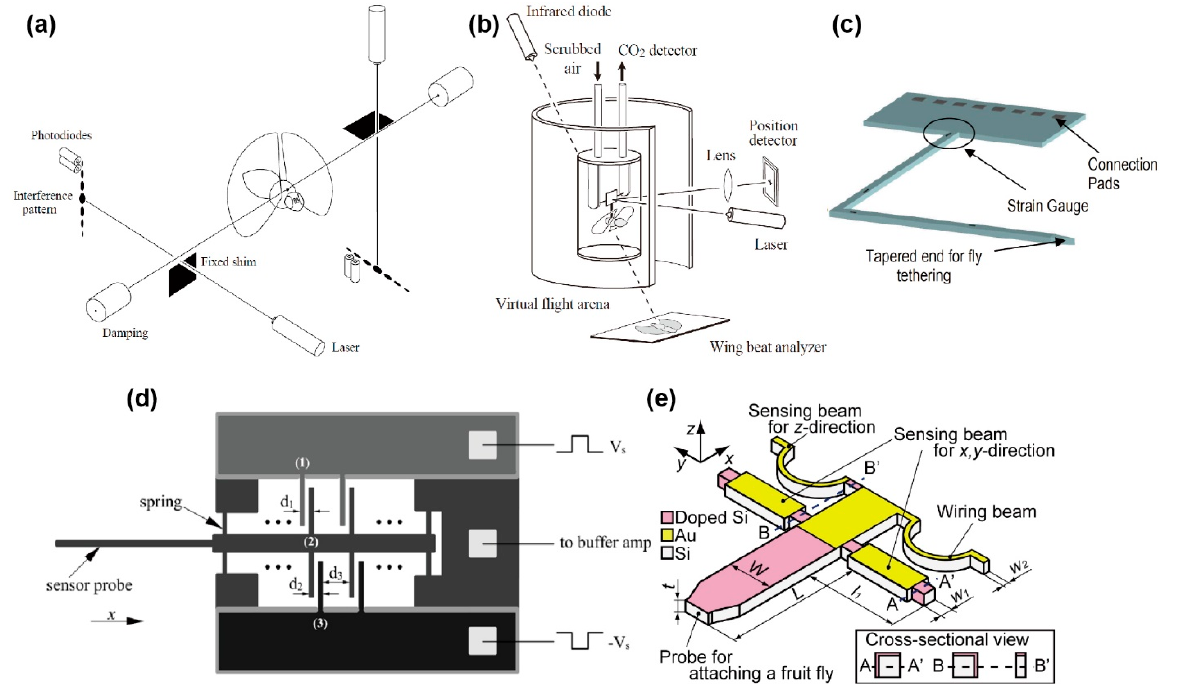
Figure 5. Schematic images of micro-force probes for flies. ( a ) Biaxial force probe using lasers and photodiodes. Reprinted/adapted with permission from [109]. 2022, Company of Biologists Ltd. ( b ) Single force probe using a laser and a photodiode. Reprinted/adapted with permission from [111]. 2022, Company of Biologists Ltd. ( c ) Biaxial MEMS piezoresistive force probe. Reprinted/adapted with permission from [30]. 2022, IEEE. ( d ) Single-axis MEMS capacitive force probe. Reprinted/adapted with permission from [31]. 2022, IEEE. ( e ) Triaxial MEMS piezoresistive force probe. Reprinted/adapted with permission from [37]. 2022, IEEE.